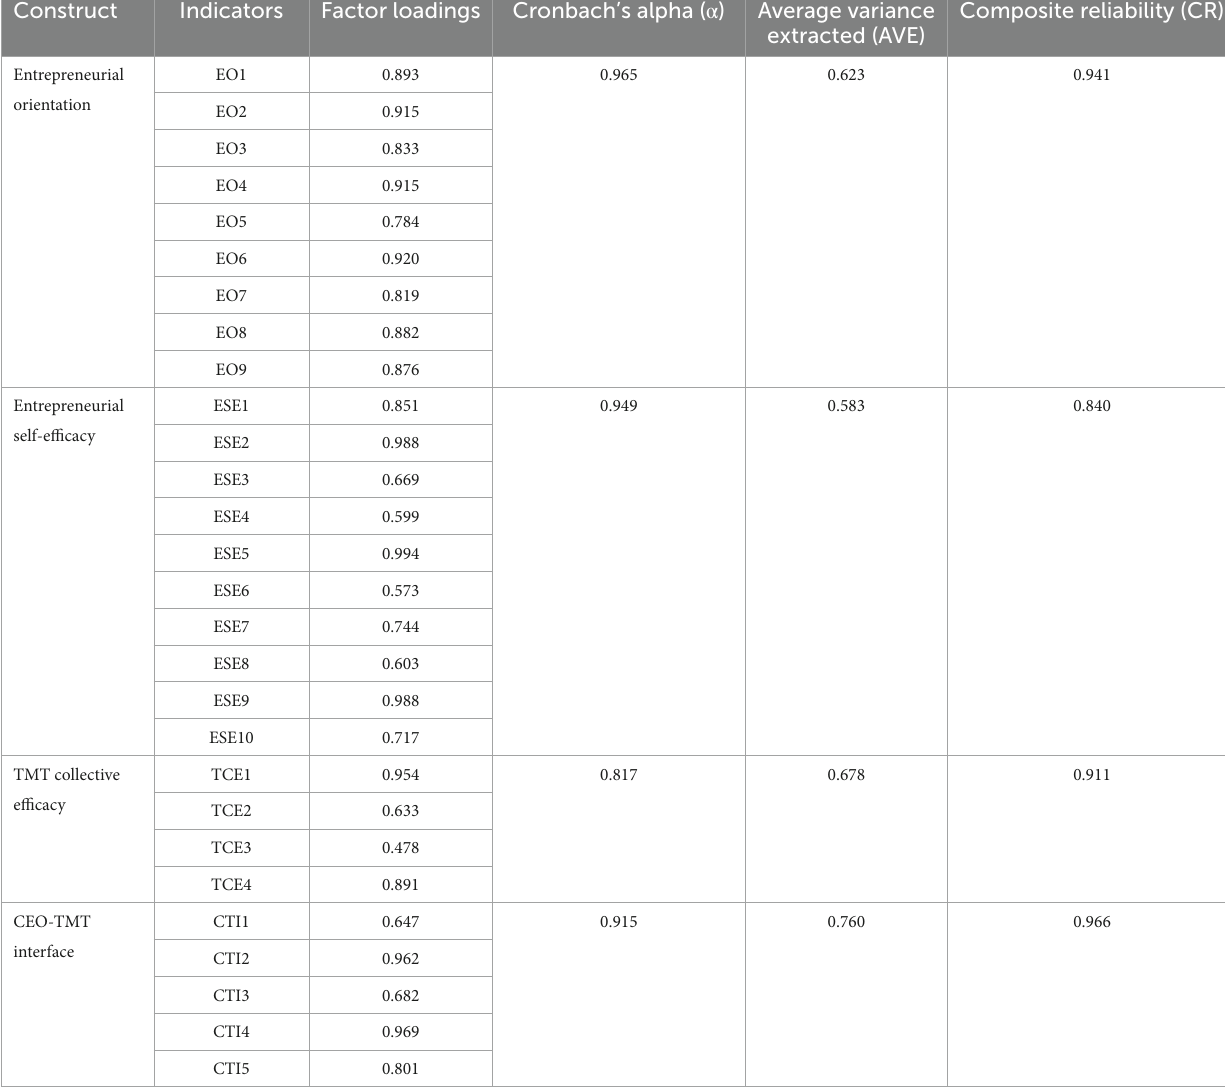
TABLE 2 Results of factor